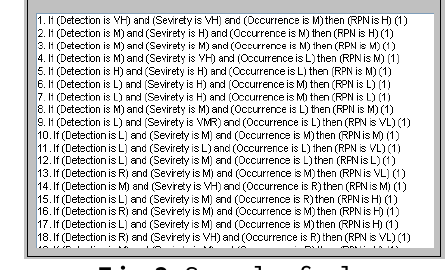
Fig. 2. The structure of designed system Fig. 3. Sample of rules